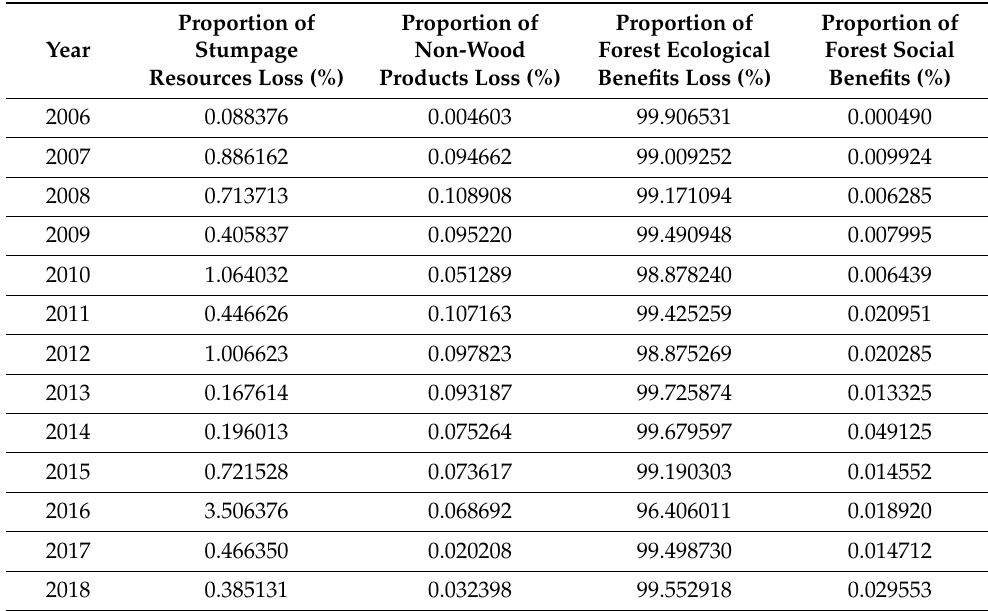
Proportion of Forest Social Benefits